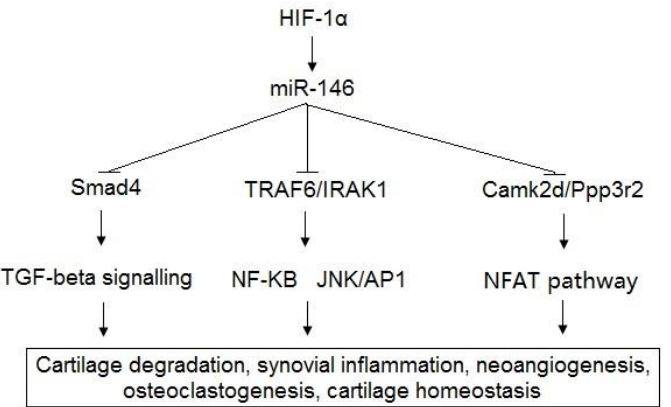
Figure 1. Schematic representation of miR-146 and its target genes related to pathogenesis of OA.